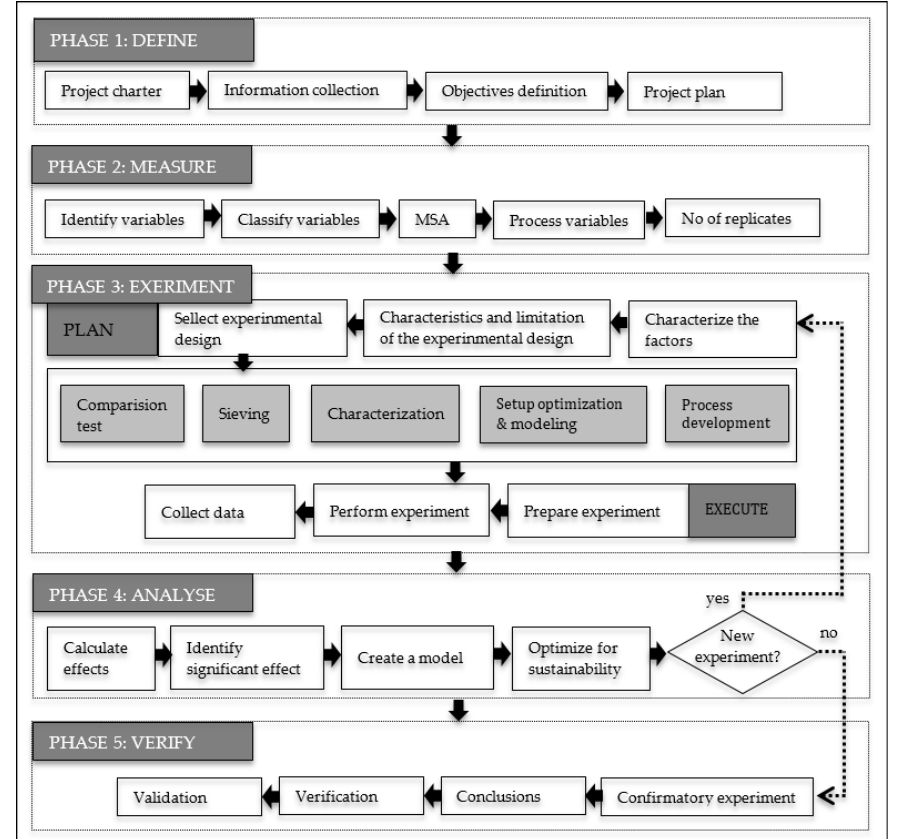
Figure 1. 3D printing DMEAV road map.